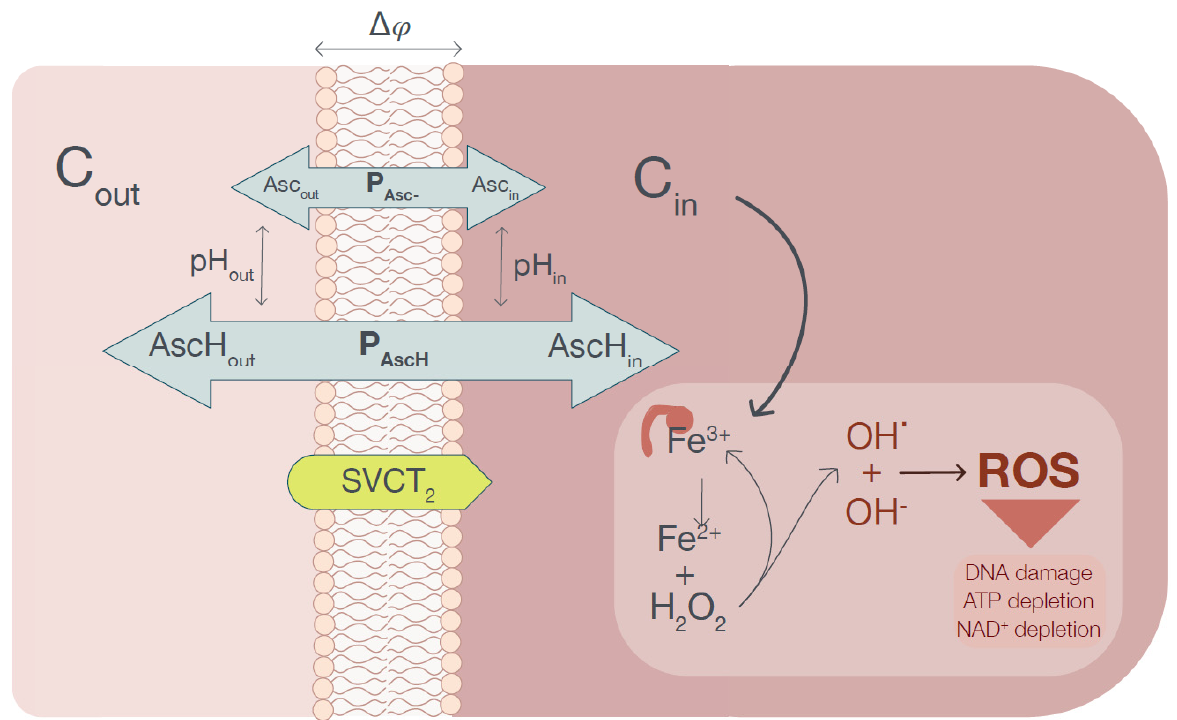
Figure 1. The graphical representation of the conceptual model used for the calculation of the steady-state intracellular ascorbate concentration. The ascorbate is transferred from the extracellular phase into a cell cytoplasm by an SVCT transporter. The generated ascorbate concentration gradient powers the passive ascorbate transport, which depends on the plasma membrane electrical potential ∆𝜑 and pH in compartments separated by the membrane. When the intracellular ascorbate reaches the level when Fe 3+ is reduced to Fe 2+ (assumed to be equal to 20 mM), the pool of labile iron increases, causing excessive ROS production leading to cell death (ferroptosis).